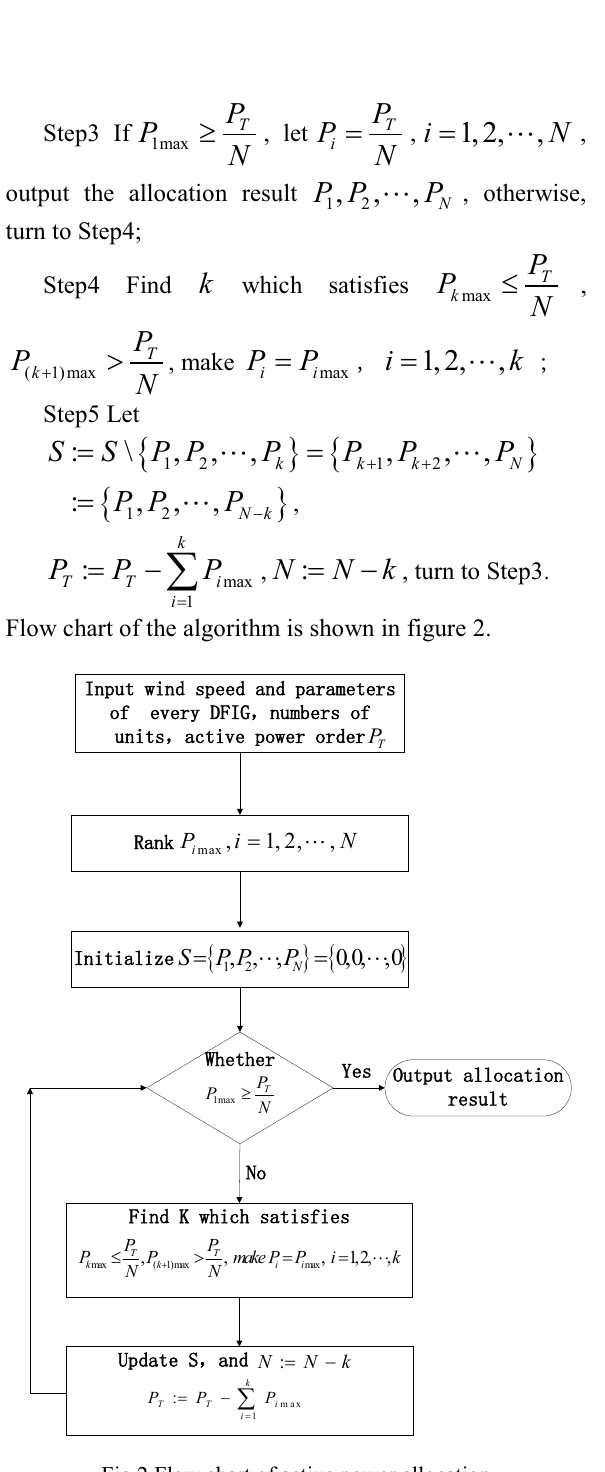
Fig.2 Flow chart of active power